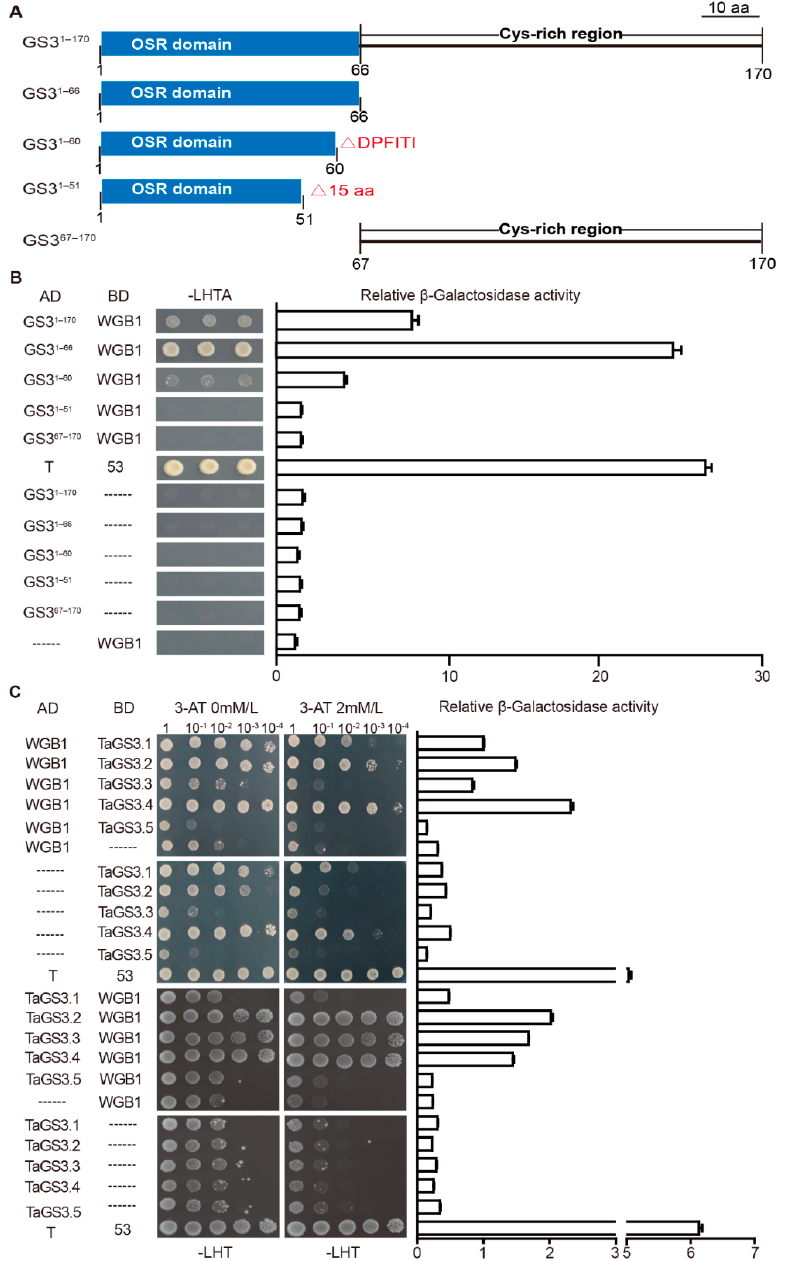
Figure 5. TaGS3 interacts with WGB1 through the OSR domain, rather than the C-terminal Cys-rich region. ( A ) Schematic structure of protein versions with specific deleted domains. ( B ) Yeast two-hybrid assay showing the interactions of full-length GS3 1–170 and the four truncated proteins (GS3 1–66 , GS3 1–60 , GS3 1–51 , and GS3 67–170 ) with WGB1. AD, GAL4 activation domain; BD, GAL4 DNA binding domain; AD and BD represent empty pGADT7 and pGBKT7 vectors, respectively. AD-T/BD-53, positive control. -LHTA, selective medium lacking Leu, His, Trp and Ade. Quantitative analyses of interactions by β -galactosidase assay were shown (on the right) as mean ± SEM (n = 3). ( C ) Yeast two-hybrid assay showing the interactions of TaGS3 isoforms with WGB1. -LHT, selective medium lacking Leu, His and Trp. The yeast strains were serially diluted (OD 600 , 10 − 1 –10 − 4 ) before spotting on selection medium-synthetic dropout interaction medium -LHT. The specificity of the stringency of the assay was tested by adding 3-aminotriazole (3-AT, 0 mM/L and 2 mM/L, respectively). Quantitative analyses of interactions by β -galactosidase assay were shown (on the right) as mean ± SEM (n = 3).